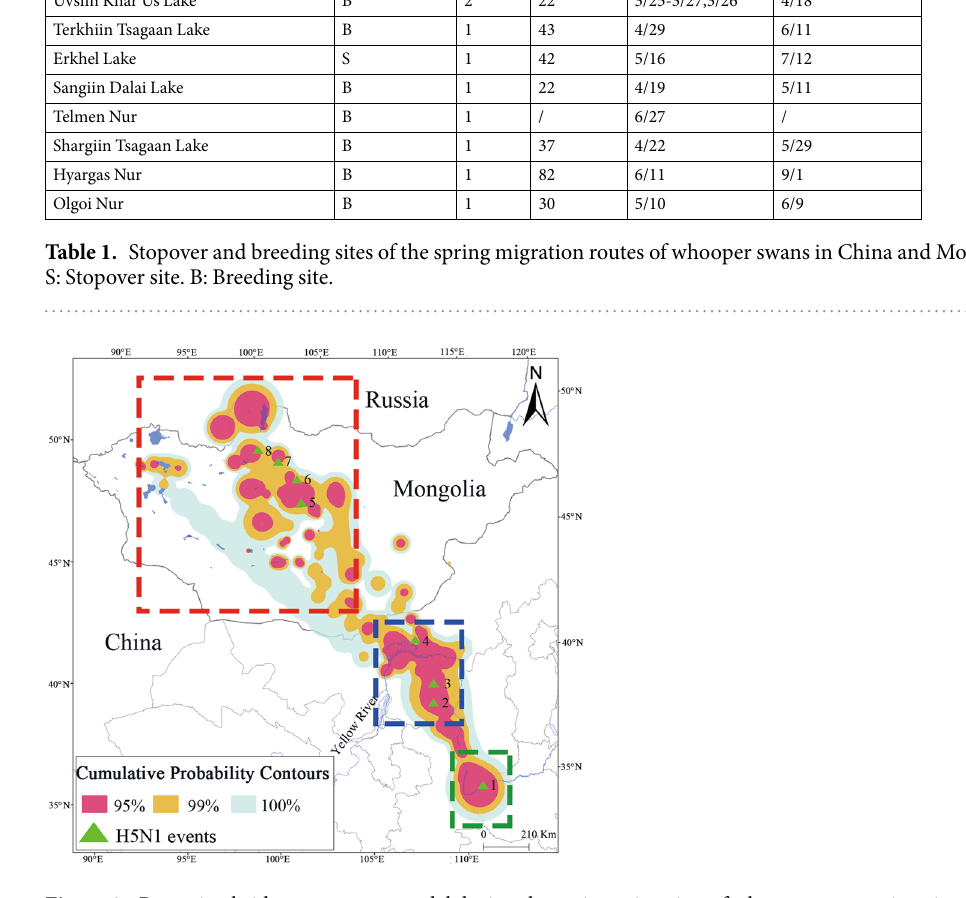
Figure 2. Brownian bridge movement model during the spring migration of whooper swans wintering at Sanmenxia Reservoir. H5N1 events: 1. Sanmenxia Reservoir area. 2. Hekou Reservoir. 3. Tsagaan Nur of Ordos. 4. Wuliangsu Lake. 5 Doitiin Tsagaan Lake. 6. Khunt Lake. 7. Doroo Nuur. 8. Erhel Lake. Different color boxes show the different months of whooper swan migration. Months have some overlap owing to individual differences in whooper swans migration. Dark blue boxes, dark green boxes and red boxes represent January to February, February to May and May to September,